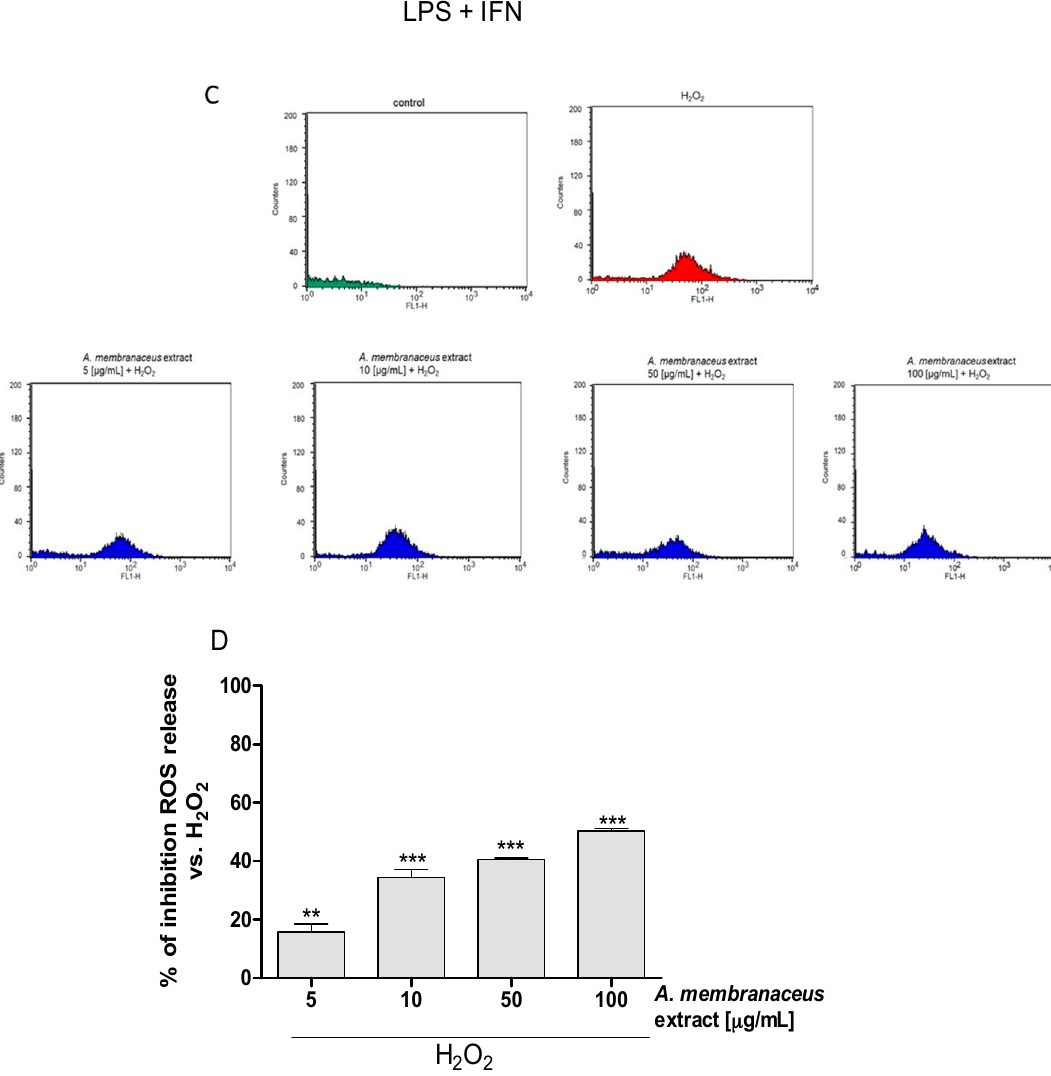
Figure 3. ( A , B ) Effect of a graded concentration of Astragalus membranaceus extract (5–100 µg/mL) in the presence of LPS + IFN on reactive oxygen species (ROS) levels, detected by 2 ′ ,7 ′ dichlorofluorescein-diacetate (H 2 DCF-DA). ( C , D ) Effect of Astragalus membranaceus extract (50 µg/mL) in the presence of H 2 O 2 on ROS formation, evaluated with the probe H 2 DCF-DA. Data are expressed as mean ± SEM. ***, ** denote p < 0.001 and p < 0.01 vs. LPS + IFN or vs. H 2 O 2 .